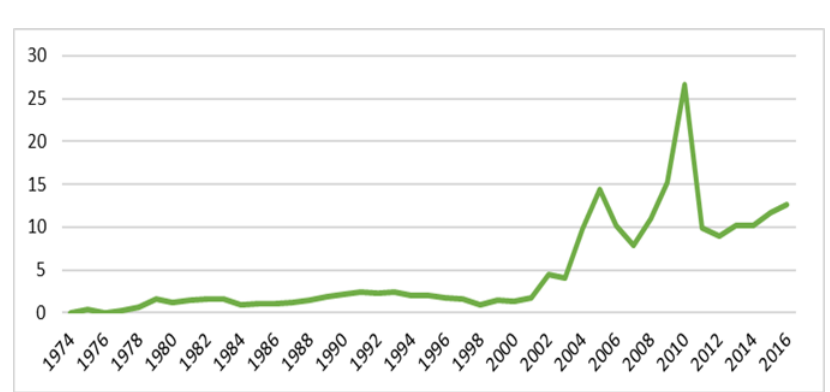
Figure A1. Annual RD&D investments for solar power in million GBP (nominal) from 1974 to 2016. Data from IEA Online Data Service. Table A1. Renewable Obligation Certificate (ROC) shares, buy-out prices, effective price per unit, and supply growth rate (in p.p) over the years (2002 – 2022). Data source: Ofgem [52].